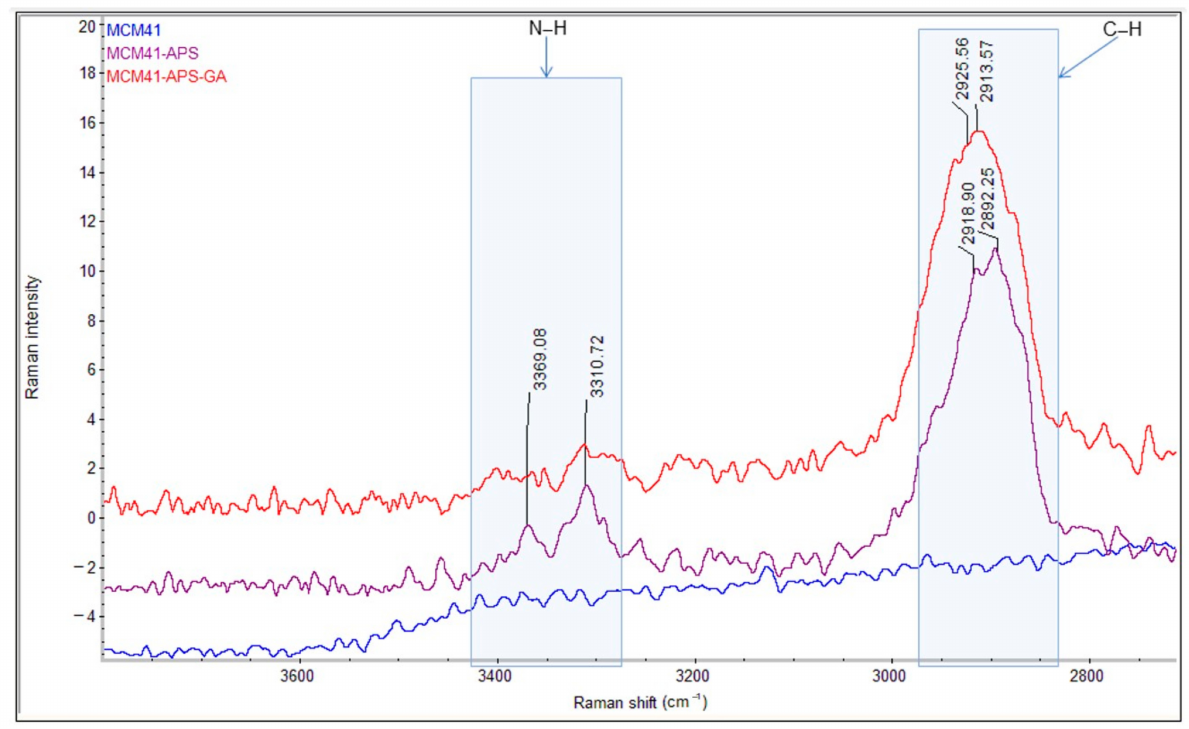
Figure 7. Comparative HATR-FT-IR spectra of MCM-41, MCM-41/APS, and MCM-41/APS/ GA materials.